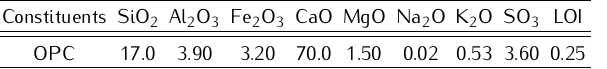
Table 1. Composition of OPC used for the